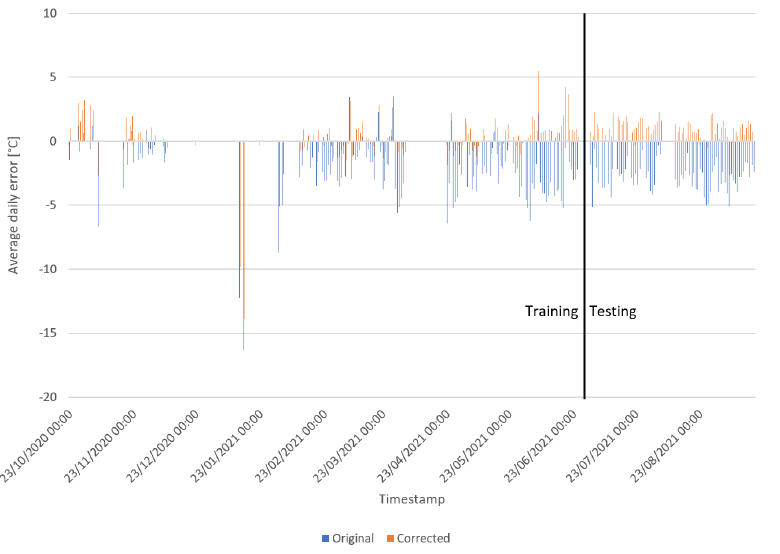
Figure 2. Overview of corrected and original T2M measurements in comparison to the forecasted T2M by